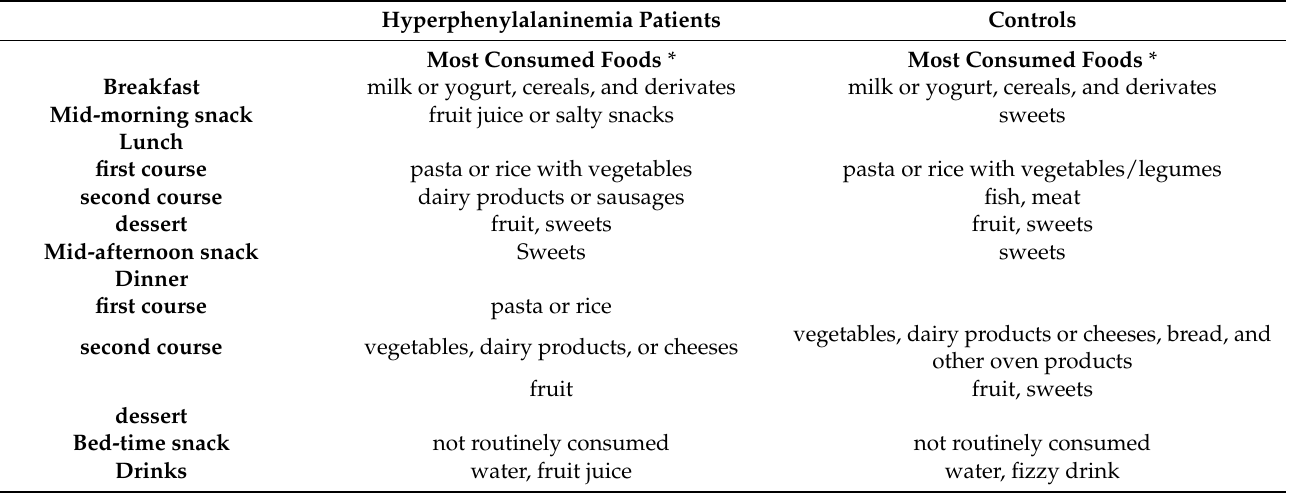
Table 2. Most consumed food analyzed by three-day food diaries in patients and controls.